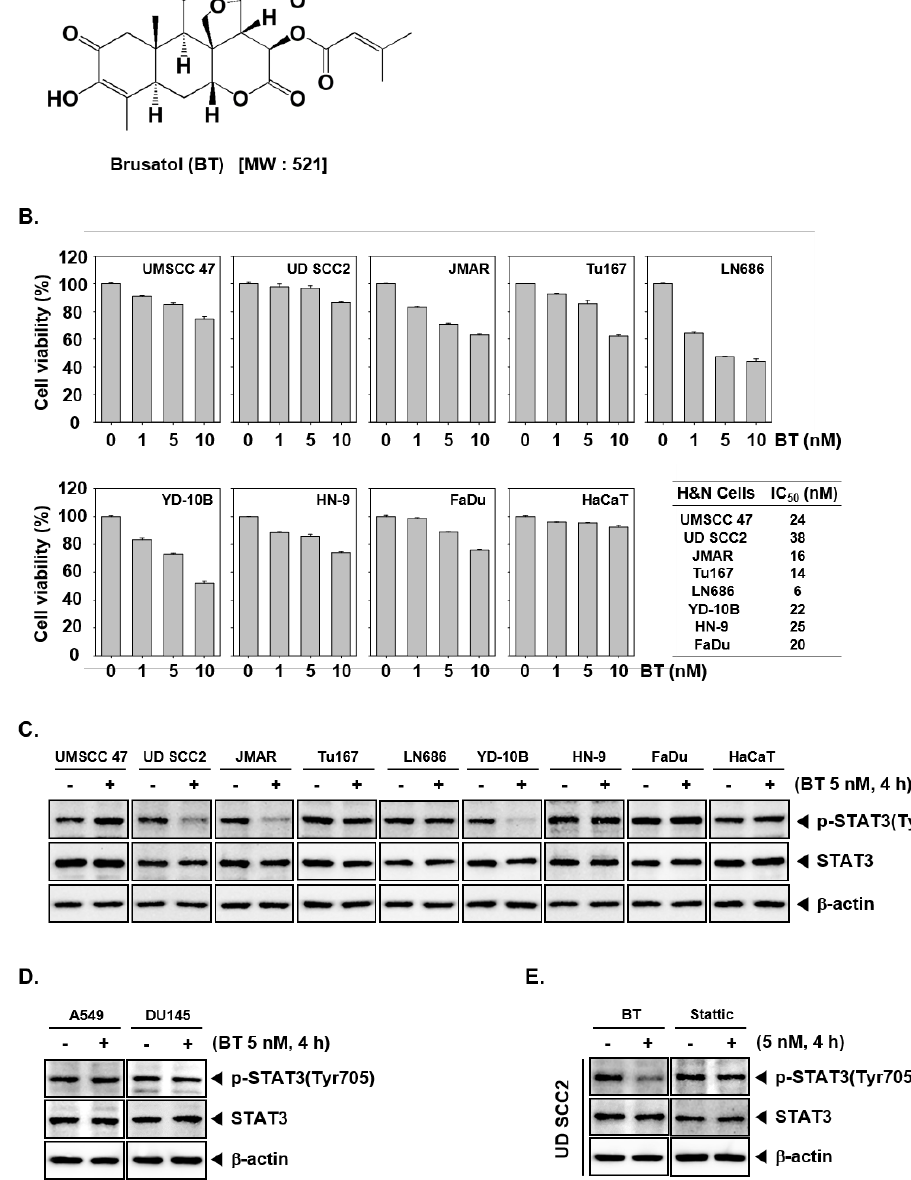
Figure 1. Brusatol (BT) suppresses cell viability and selectively blocked the activation of STAT3 in head and neck squamous cell carcinoma (HNSCC). ( A ) The chemical structure of Brusatol (BT). ( B ) HNSCC cells (UMSCC 47, UD SCC2, JMAR, Tu167, LN686, YD-10B, HN-9, and FaDu) and HaCaT cells were treated with various concentration of BT for 24 h, and cell viability was determined by 3-(4,5-Dimethylthiazol-2-yl)-2,5-diphenyltetrazolium bromide (MTT) assay. ( C ) HNSCC cells (UMSCC 47, UD SCC2, JMAR, Tu167, LN686, YD-10B, HN-9, and FaDu) and HaCaT cells were treated with 5 nM of BT for 4 h. Thereafter, equal amounts of lysates were analyzed by western blot analysis. β -actin was used as an input control to verify equal protein loading. ( D ) A549 and DU145 cells were treated with 5 nM of BT for 4 h. Thereafter, equal amounts of lysates were examined by western blot analysis. ( E ) UD SCC2 cells were treated with 5 nM of BT or static for 4 h. Thereafter, equal amounts of lysates were examined by western blot